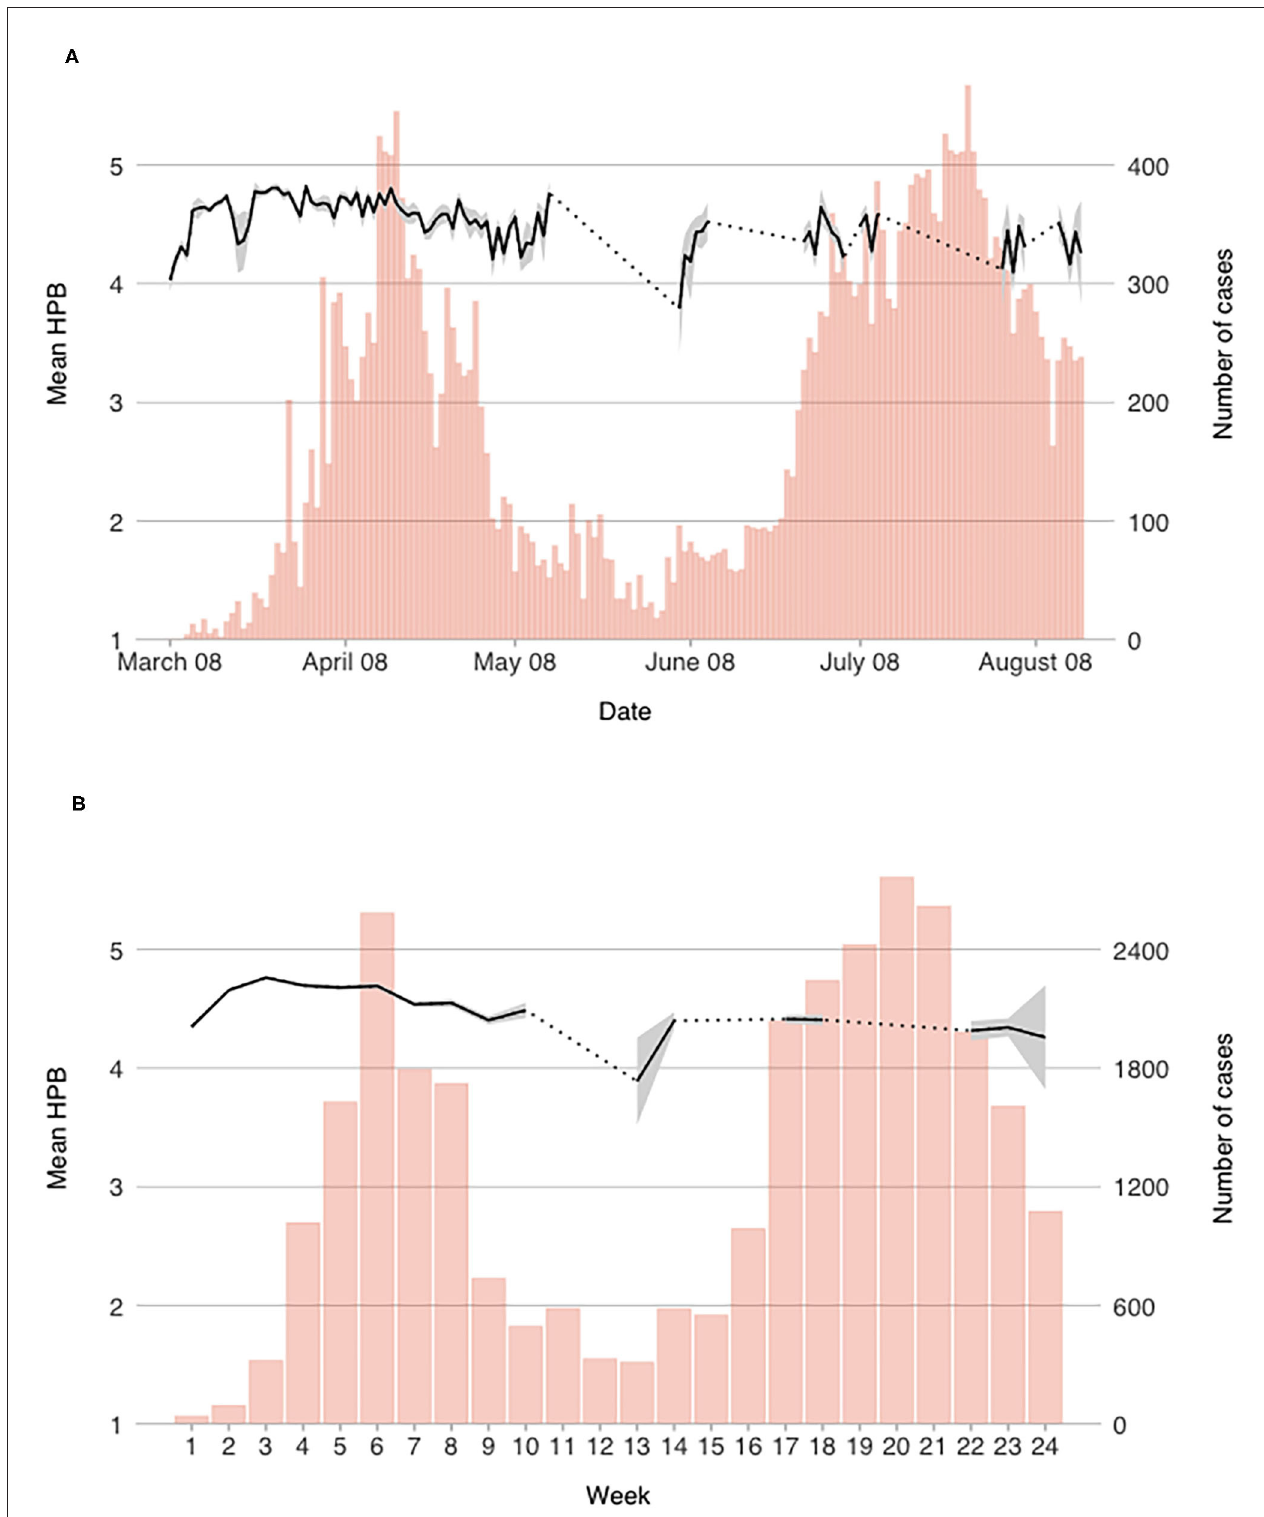
FIGURE 4 | Mean reported engagement in hypothetical protective behavior on a (A) daily, and (B) weekly level.